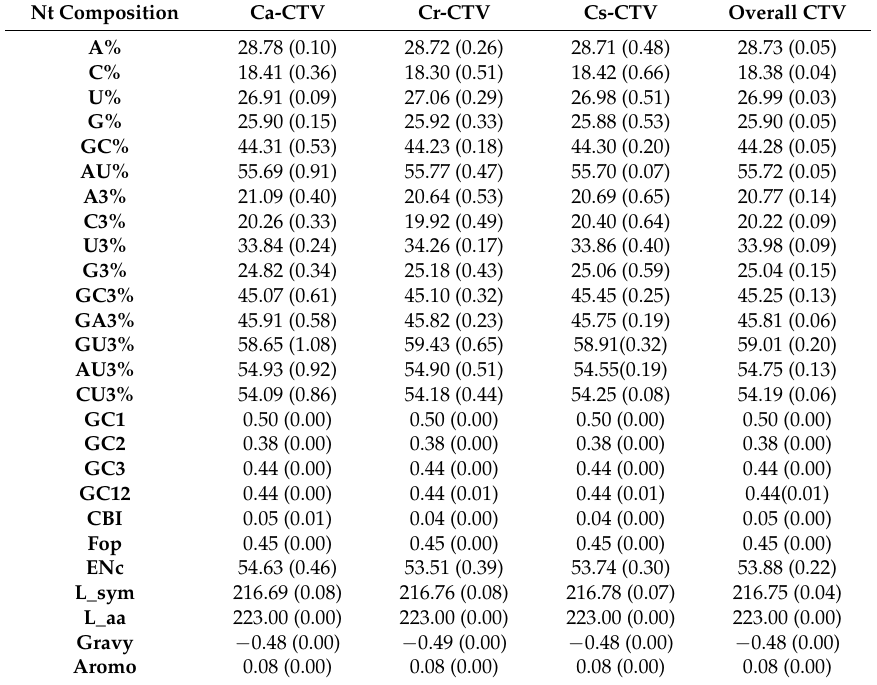
Table 1. Nucleotide (Nt) contents of coat protein ( CP ) genes of Citrus tristeza virus